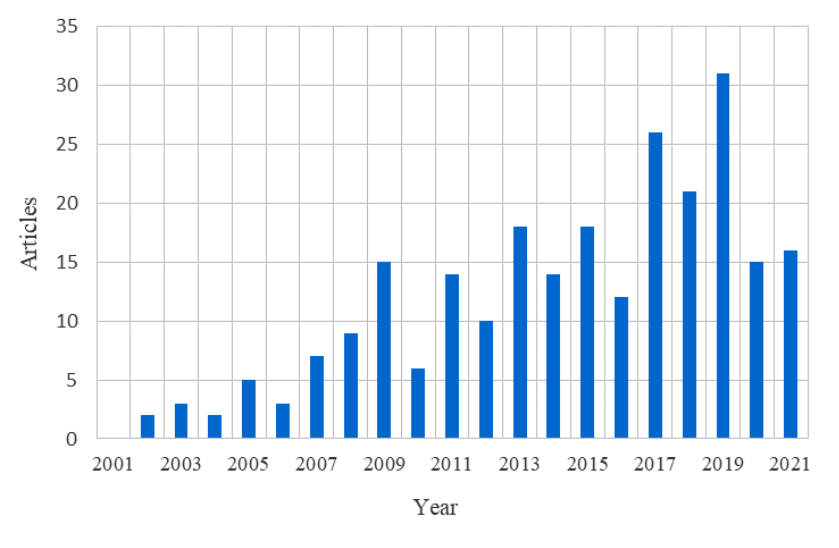
Figure 2. Articles published in the last 20 years, which were gathered using the keywords “guided wave ultrasonic testing, signal